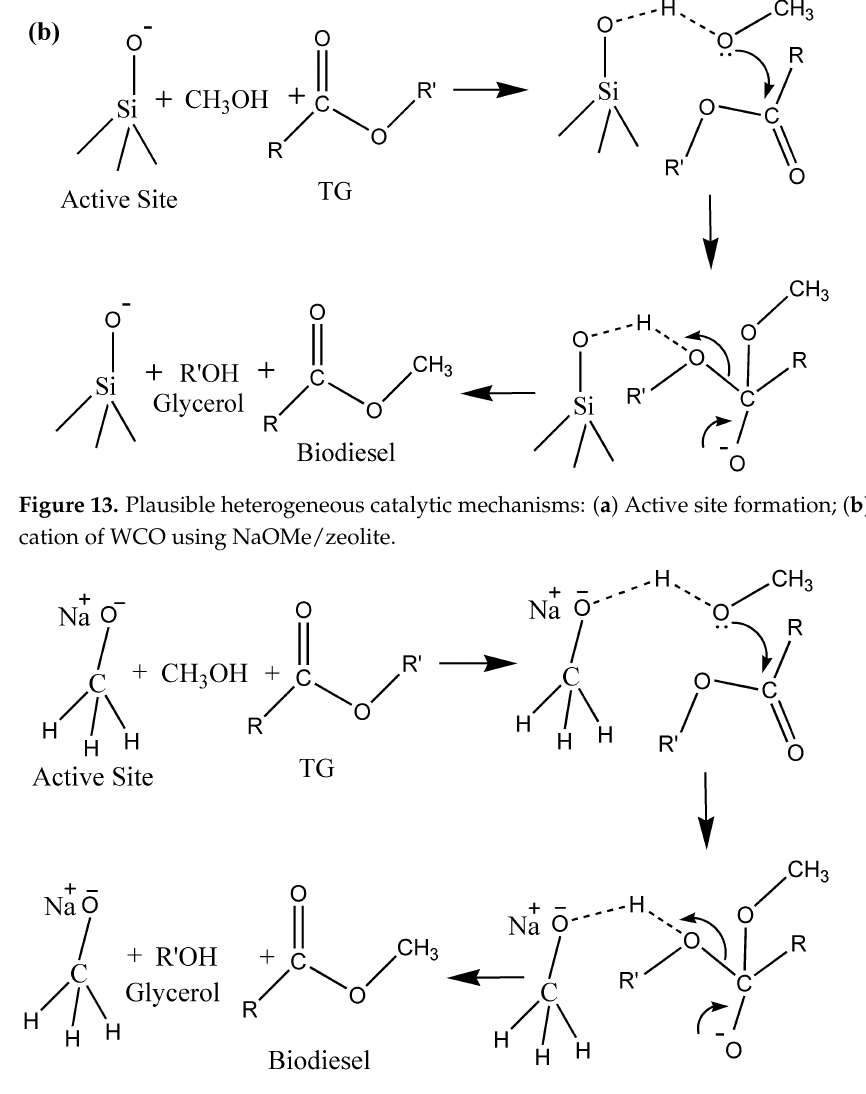
Figure 14. Plausible homogeneous catalytic mechanism of transesterification of WCO us- ing